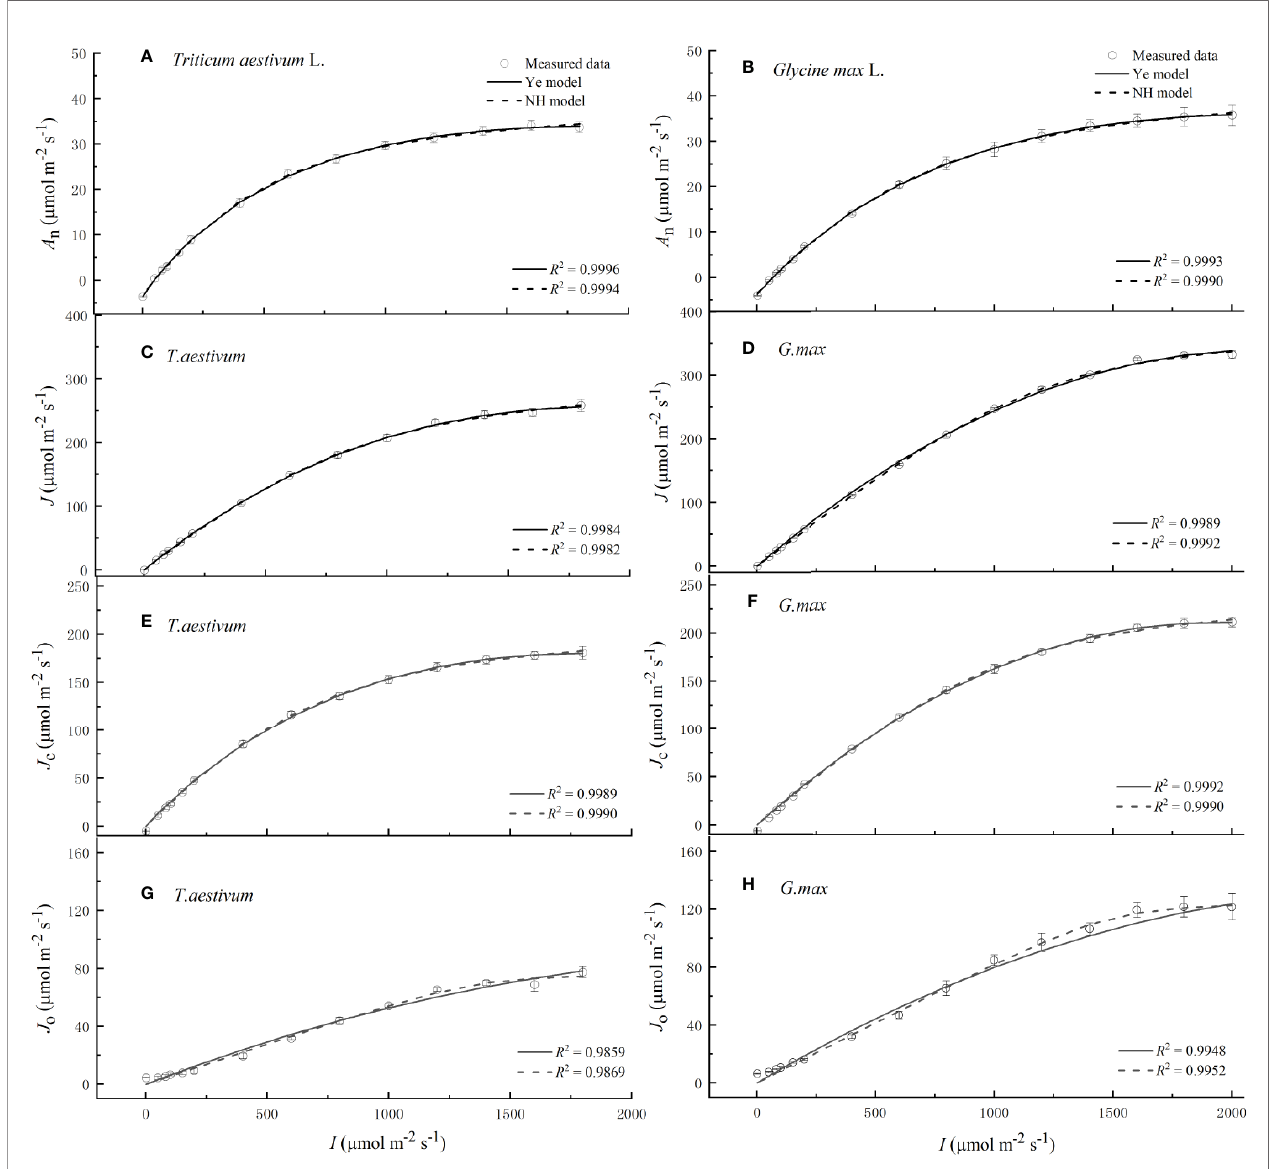
FIGURE 1 | Light response curves of net photosynthetic rate (A, B), electron transport rate (C, D), electron fl ow for RuBP carboxylation (E, F) and the electron fl ow for RuBP oxygenation (G, H) for winter wheat ( Triticum aestivum L.) and soybean ( Glycine max L.), respectively, over the irradiance range from 0 to 2000 m mol m − 2 s − 1 . Solid curves were fi tted using Ye model, and dash curves were fi tted using NH model. Values are means ± standard errors ( n =